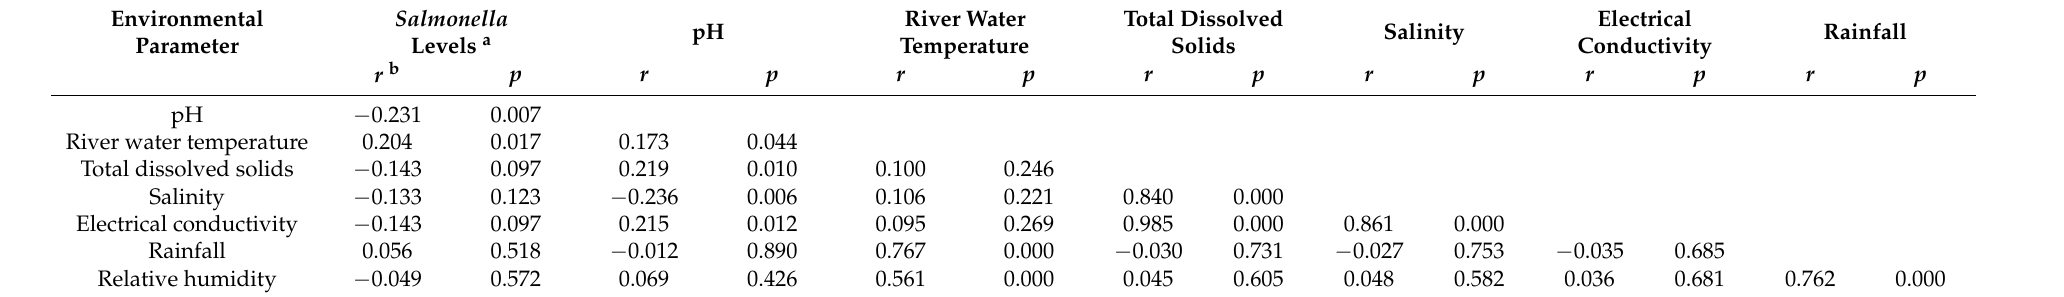
Table 2. Pearson’s correlation coefficients ( r ) and p -values ( p ) determined for the environmental parameters and Salmonella detection levels for all sampling sites throughout the sampling period.